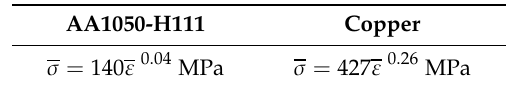
Table 2. Stress–strain curves for the AA1050-H111 and copper sheets.